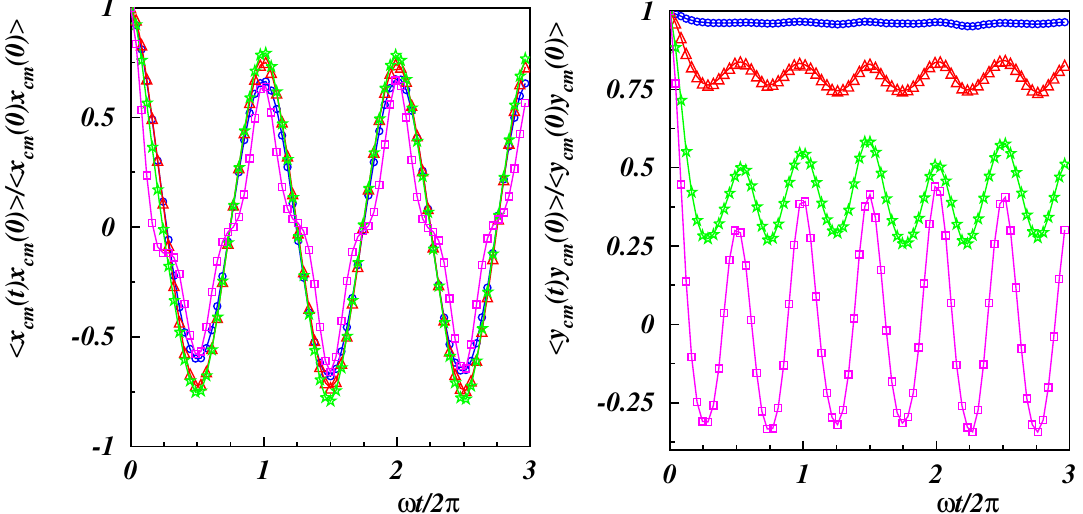
Figure 10. Autocorrelation function of center-of-mass Cartesian coordinates as a function of time along the x - ( left ) and y -direction ( right ). The polymer stiffness is L p / L = 2 and the Weissenberg numbers ) Wi = 10 ( ◦ ) ,25 ( (cid:52) ) ,50 ( (cid:63) ) ,100 ( (cid:50)